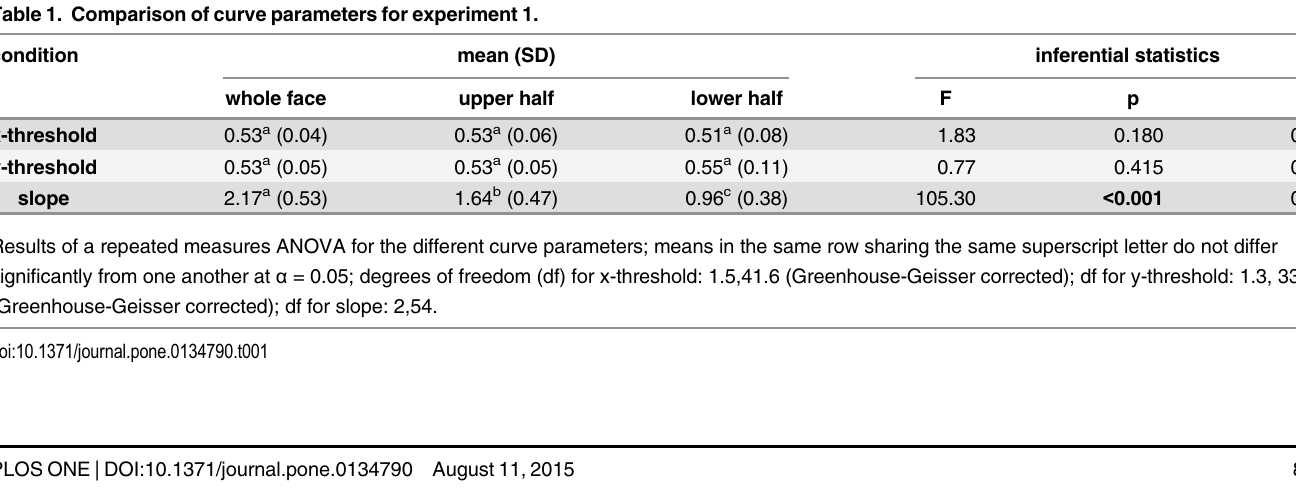
Table 1. Comparison of curve parameters for experiment 1.